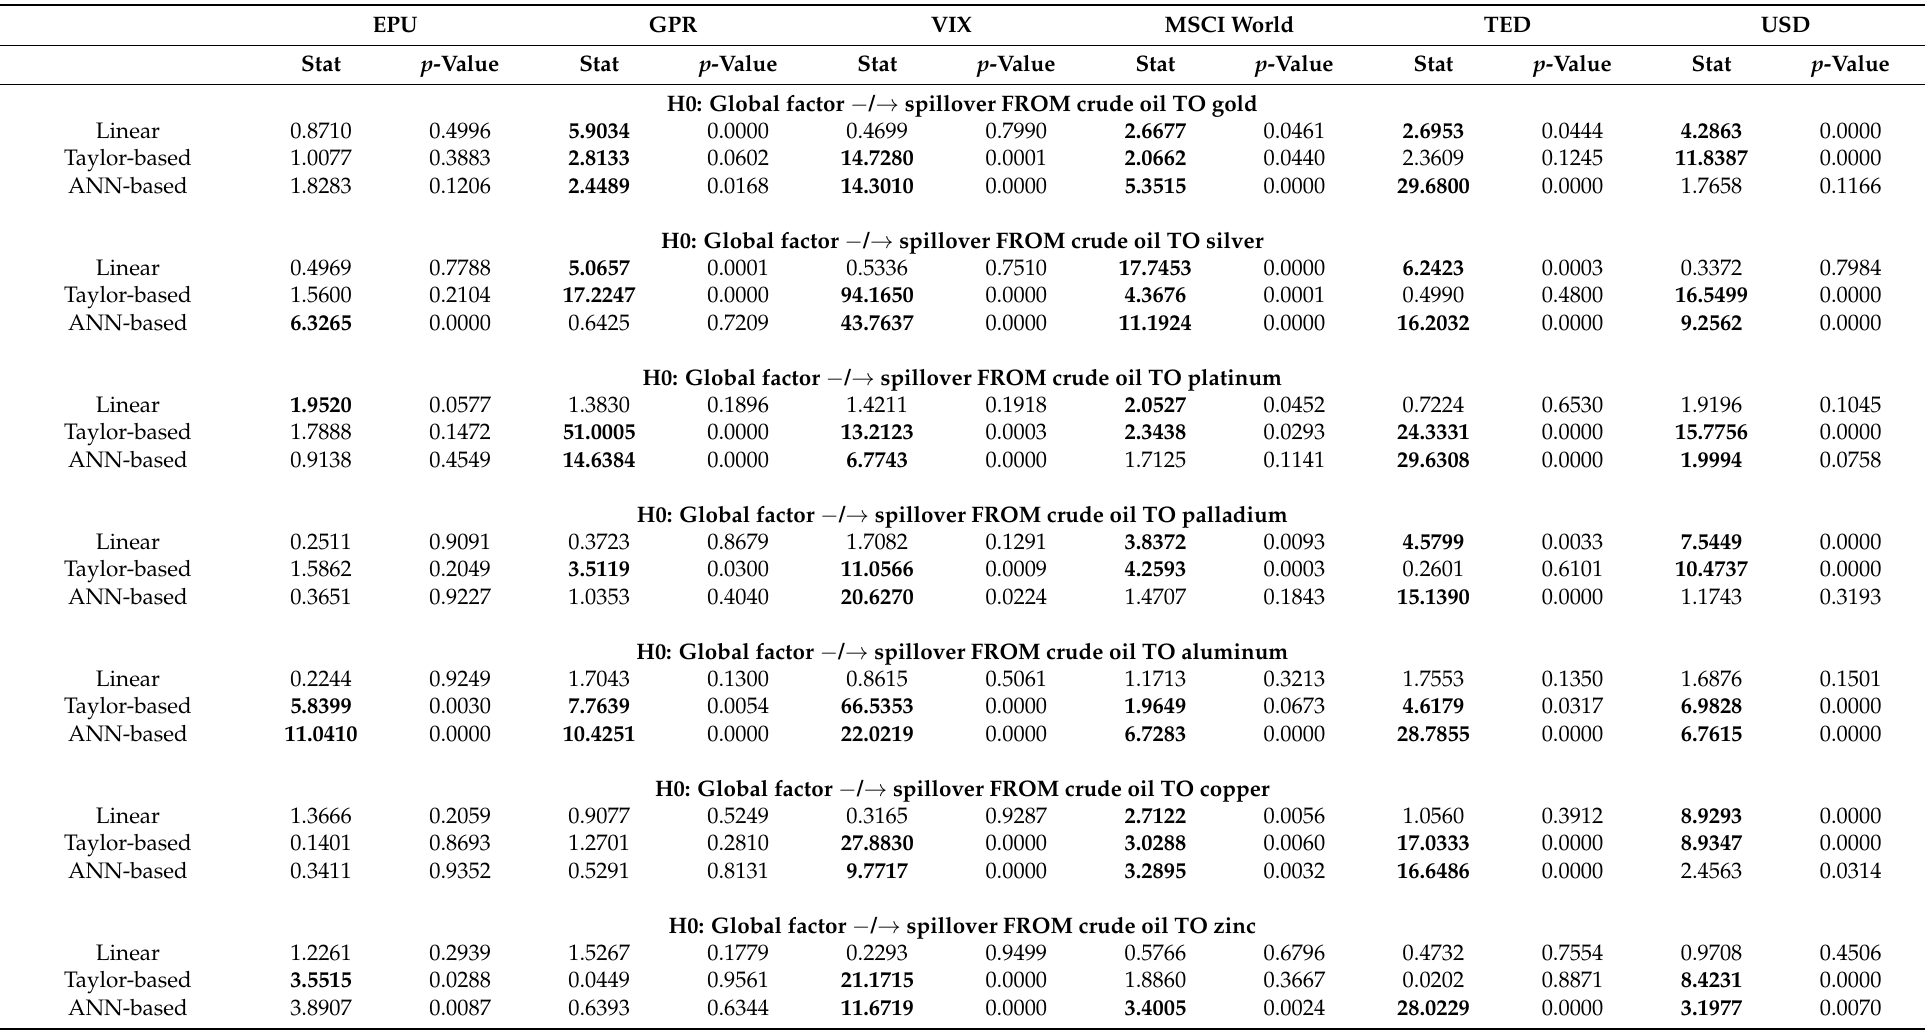
Table 4. Linear and nonlinear causality tests for spillovers from oil to individual commodity uncertainties (full